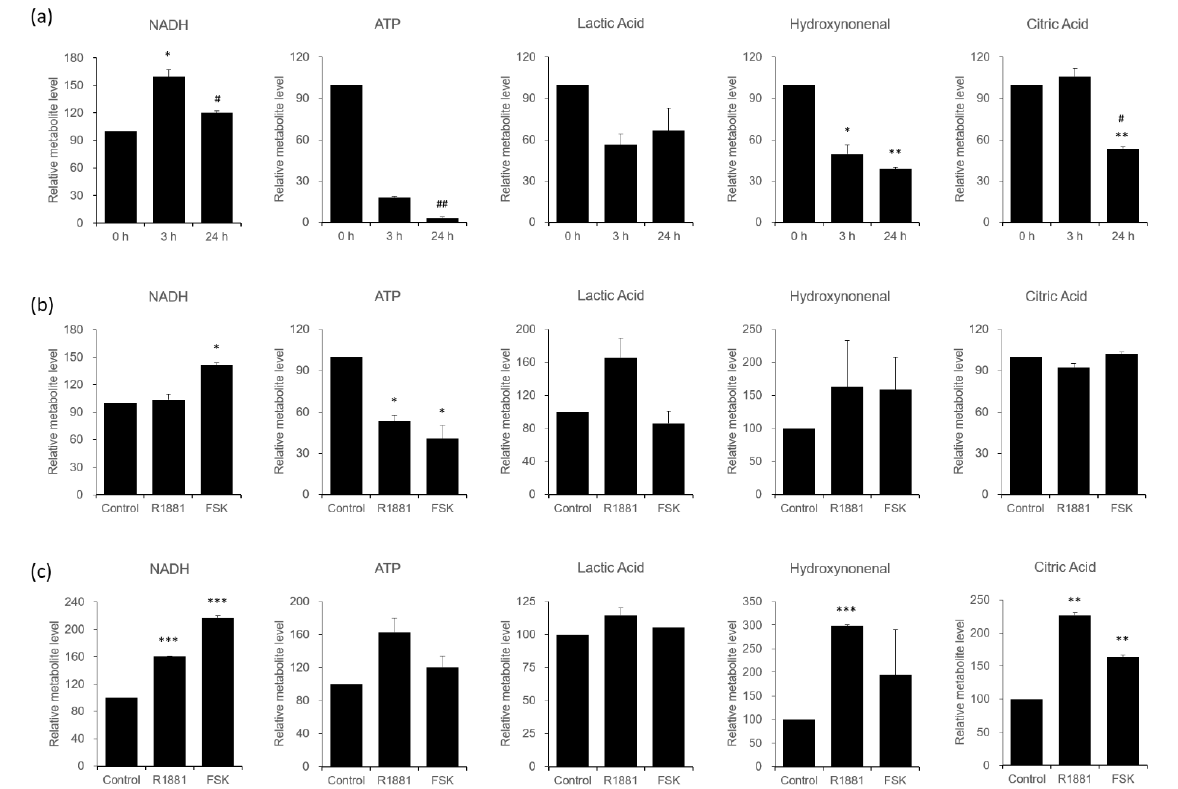
Figure 5. Determination of the differential expression levels of metabolites, NADH, ATP, lactic acid, hydroxynonenal, and citric acid in VCaP cells. Metabolite concentrations modulated by R1881 and FSK were measured in VCaP cells at 3 and 24 h. ( a ) The time course of changes in metabolites, measured in serum-starved VCaP cells. ( b ) Changes in metabolites associated with androgen or PKA signaling pathways, measured at 3 h. ( c ) Changes in metabolites associated with androgen or PKA signaling pathways, measured at 24 h. Statistical significance is indicated as follows: ( a ): * p < 0.05, ** p < 0.01 when compared with non-starved control group, # p < 0.05, ## p < 0.01 when compared with 3-h serum-starved group. ( b ): * p < 0.05 when compared with untreated control group. ( c ): ** p < 0.01, *** p < 0.001 when compared with the untreated control group.